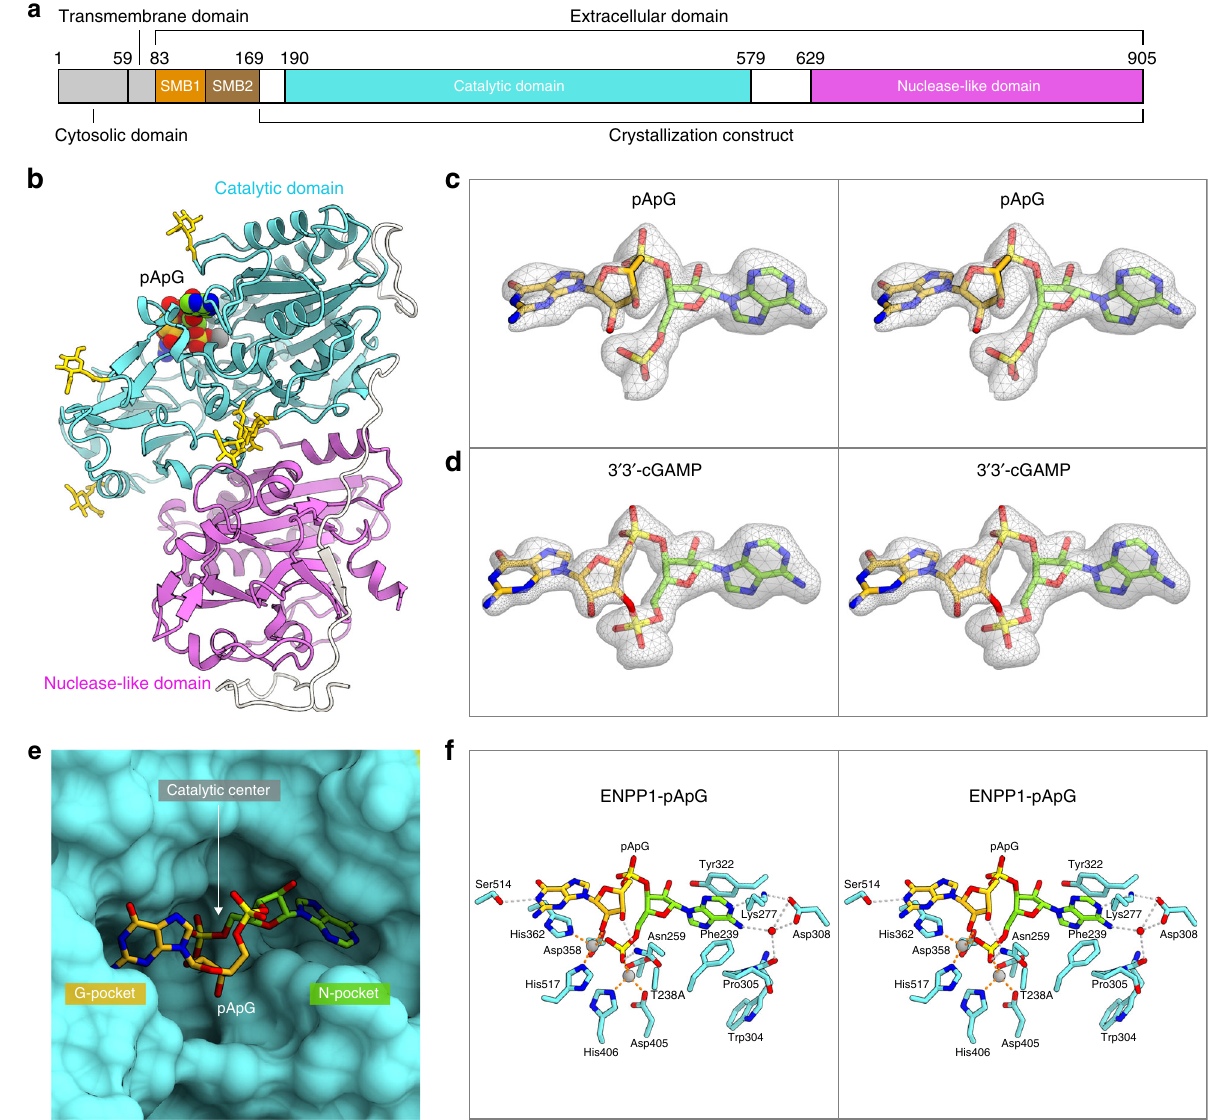
Fig. 2 Crystal structure of ENPP1 in complex with the dinucleotide. a Domain organization of mouse ENPP1. b Overall structure of ENPP1 in complex with pApG. The N-linked sugars are shown as yellow sticks. c , d mF O – DF C omit electron density maps for pApG ( c ) and 3 ′ 3 ′ -cGAMP ( d ) (contoured at 2.5 σ ) (stereo view). e Binding of pApG to the ENPP1 active site. f Recognition of pApG (stereo view). The zinc ions are shown as gray spheres. Hydrogen bonds are shown as dashed